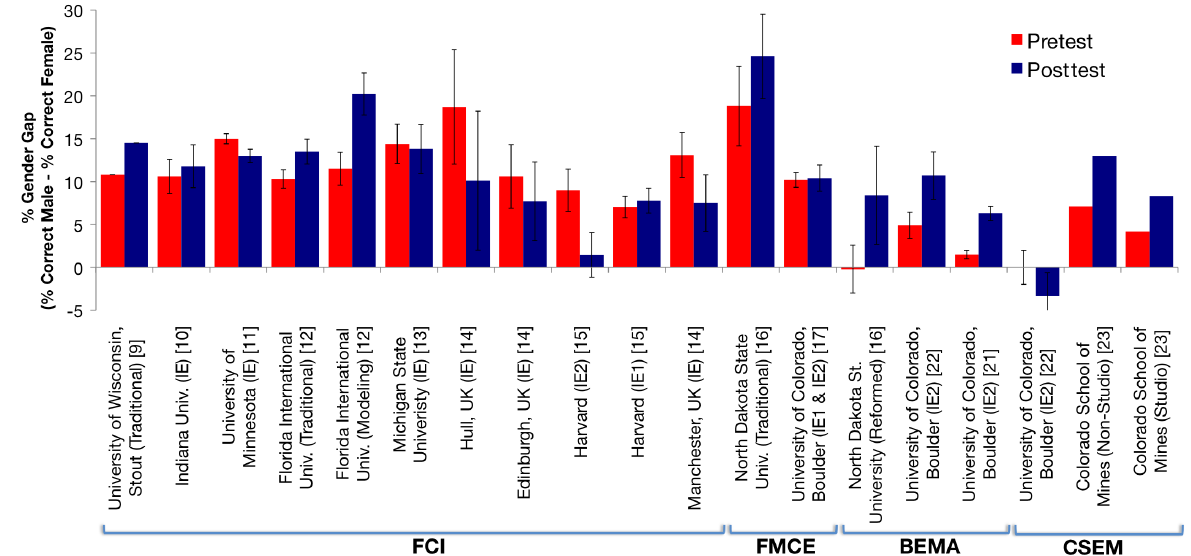
FIG. 3 (color online). Gender gap in percentage on pre- and posttest across several institutions on the FCI, FMCE, BEMA, and CSEM. The gender gap changes differently in each situation. Sometimes it increases from pre- to posttest, other times it decreases or stays the same. The way the gender gap changes from pre- to posttest does not seem to be related to type of instruction (interactive engagement or traditional). Error bars represent the standard error. If no error bars are present, they were not reported in the study.